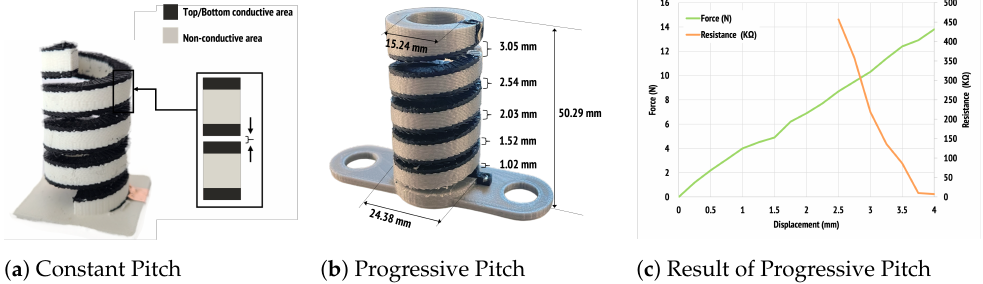
Figure 5. The different design of conductive layer to maximize the change of resistance—( a ) constant pitch, ( b ) progressive pitch, and ( c ) the result of the progressive pitch